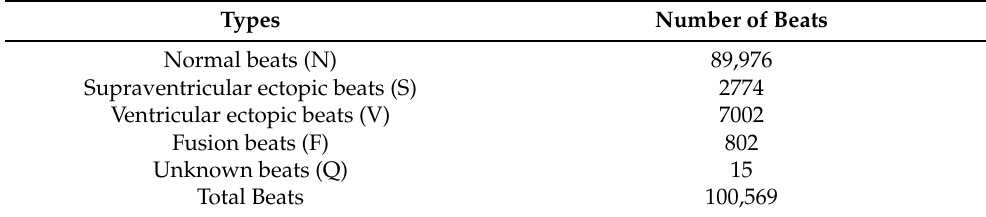
Table 2. Summary of ECG